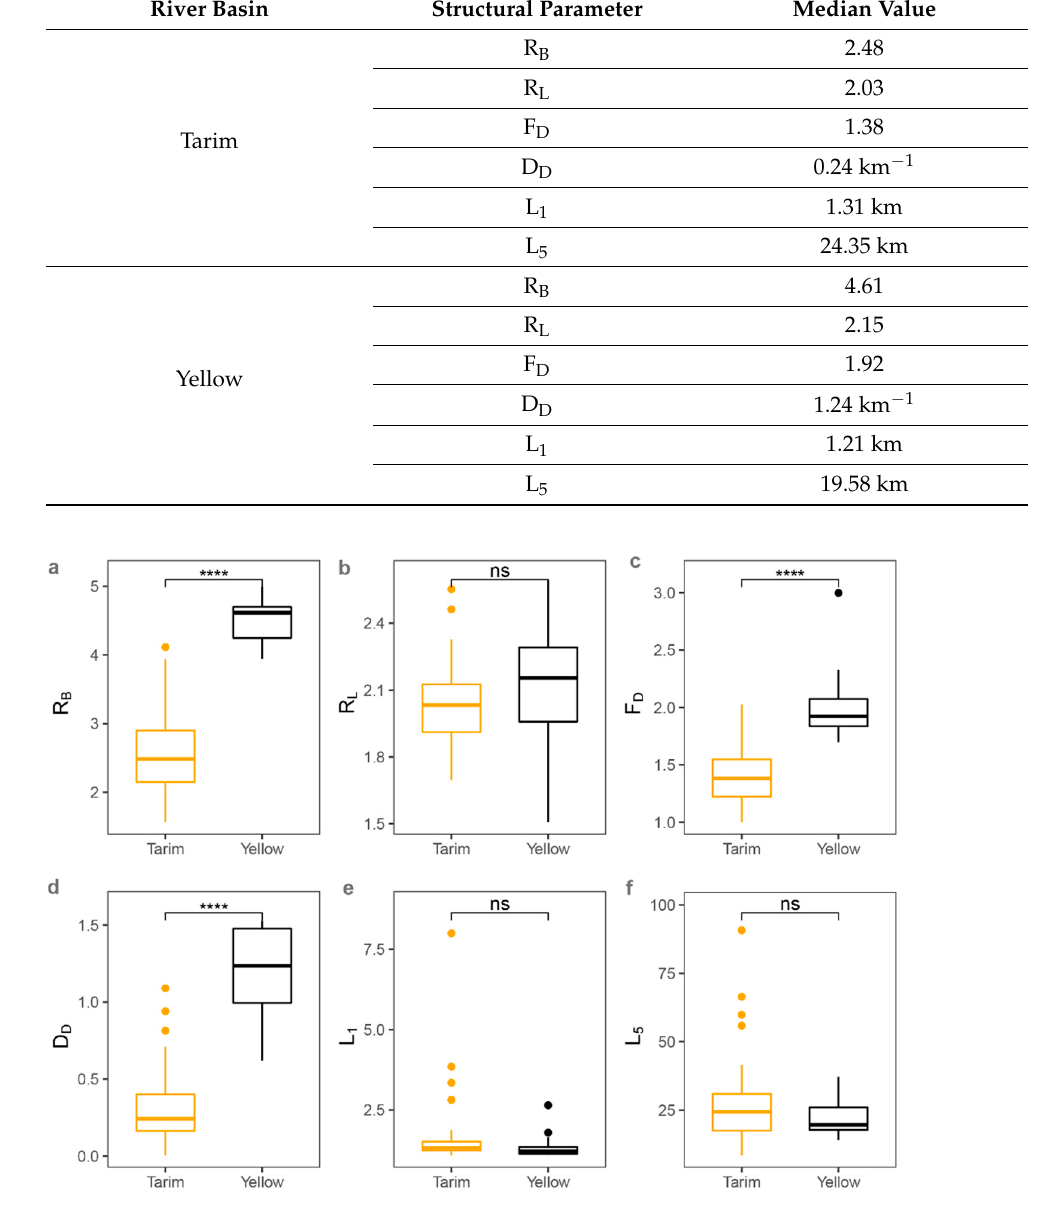
Figure 8. Comparison of structural parameters between the Tarim River and the Yellow River